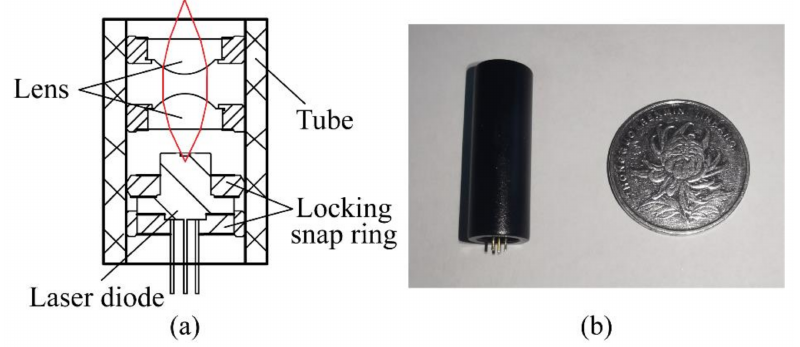
Figure 3. Optical system. ( a ) Structural drawing, the red line is the focused optical path; ( b ) Photo- graph of the optical system.